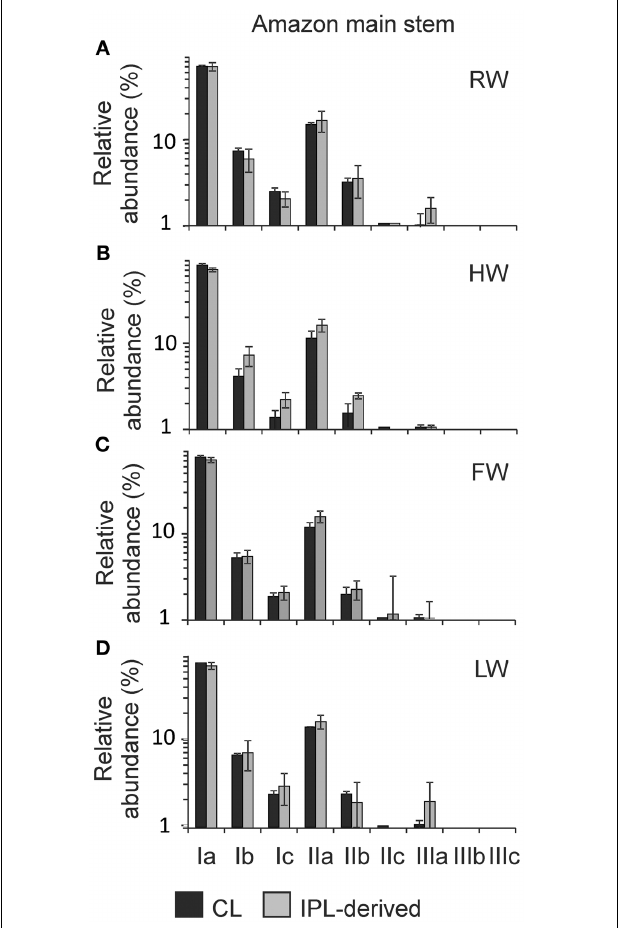
FIGURE 7 | Distribution patterns of the average relative abundances of CL and IPL-derived brGDGTs for the Amazon main stem during (A) RW, (B) HW, (C) FW, and (D) LW seasons. Note that the y axes are logarithmic scales.